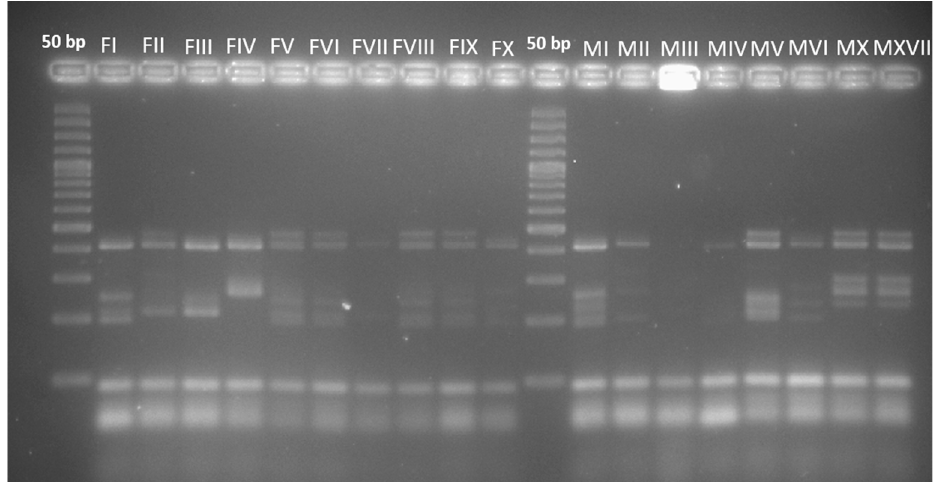
Figure 1. Patterns obtained by the simple sequences repeats (SSR)-Multiplex PCR of the S. cerevisiae flor yeasts, selected after the first screening. Strains FII and FIII, FV and FVI, FVIII and FIX, MX and MXVIII showed common patterns.